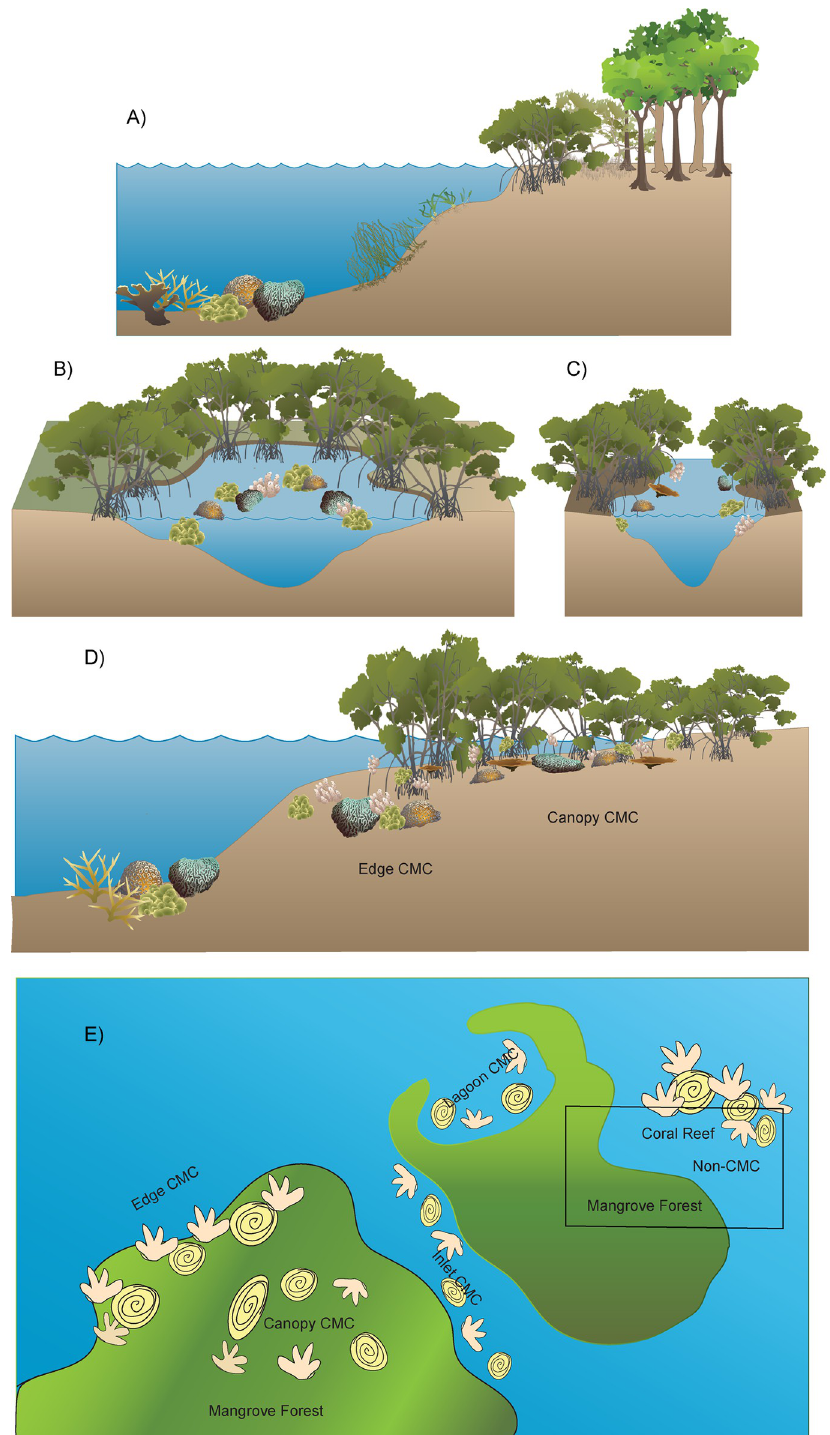
Fig 6. Coexisting mangrove-coral (CMC) assemblage types. (A) Non-CMC: discrete adjacent assemblage of coral reefs and mangrove forests. (B) Lagoon CMC: corals along semi-enclosed mangrove lagoons outside the shade of the mangrove canopy, but close enough for biogeochemical influence. (C) Inlet CMC: corals along mangrove channels partially under shade. (D) Edge CMC: partially or completely shaded corals grow on and around mangrove roots along the fringe of the mangrove and Canopy CMC: corals grow completely under the mangrove canopy with the lowest